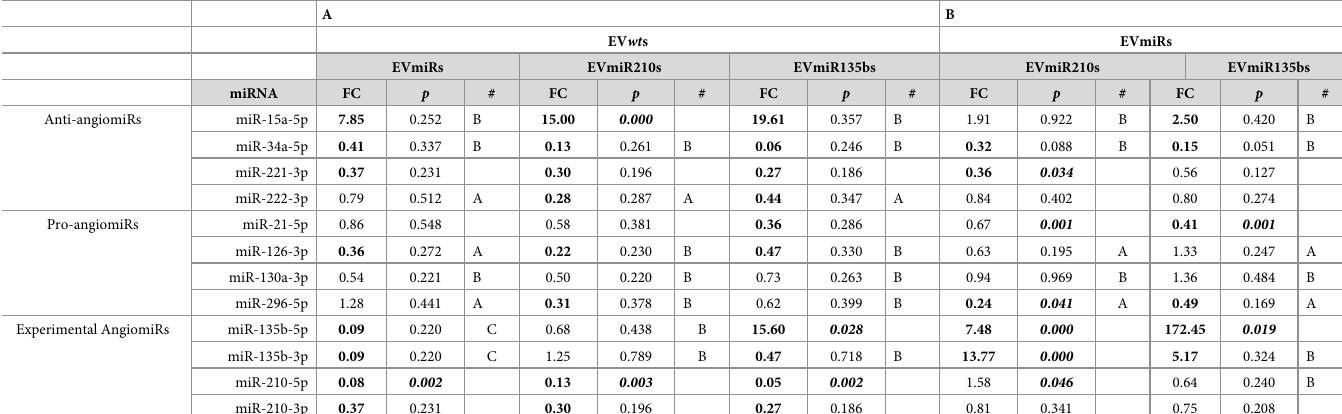
Table 3. miRNA expression in MSC-EVs compared with that in EV wt s and EVmiRs (control